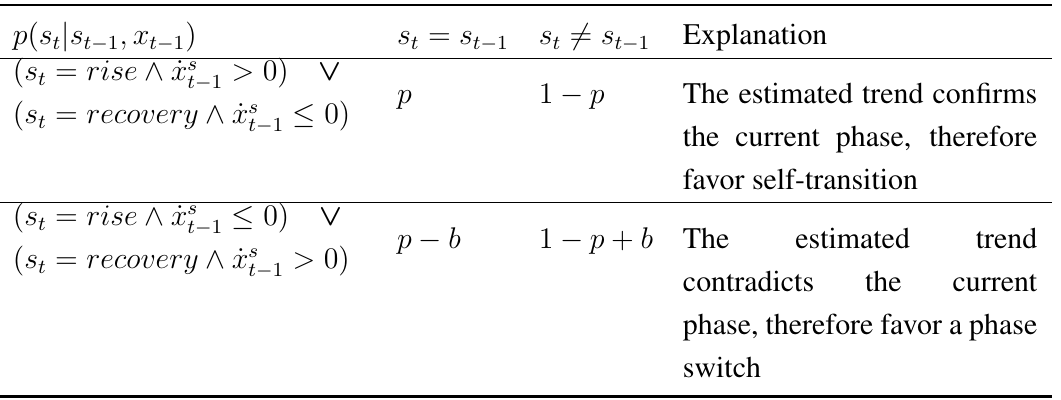
Table 1. Explanation of the proposed aSLDS transition model.